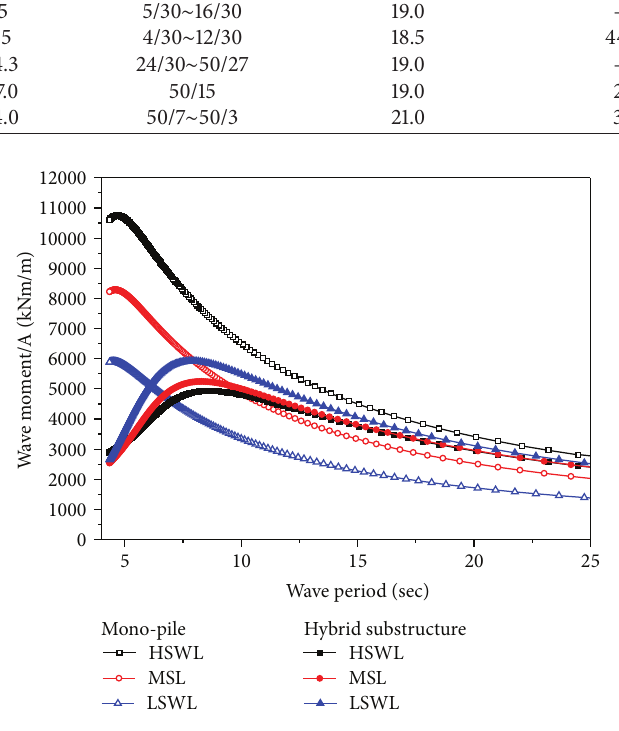
Figure 5: Comparison of wave moments for various water depths.